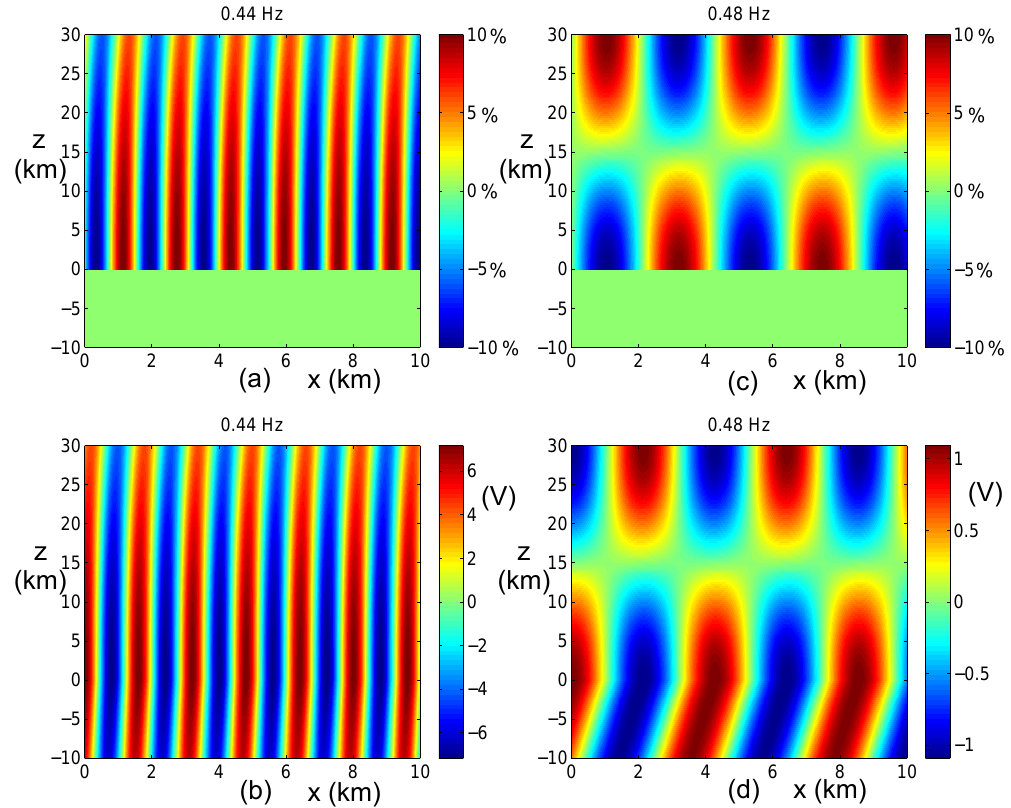
Fig. 7. Comparison of density and potential eigenfunctions below and above cutoff of the thin-layer mode, for 120 km altitude layer with 100mVm − 1 electric field. Panel (a) shows the percentage density perturbation for the mode with the highest growth rate just below cutoff (the thin-layer mode). Panel (b) shows the associated potential function for the thin-layer mode just below cutoff. Panel (c) shows the percentage density perturbation just above cutoff, for the remaining mode with the highest growth rate. Panel (d) shows the associated potential function just above cutoff, for the remaining mode with the highest growth